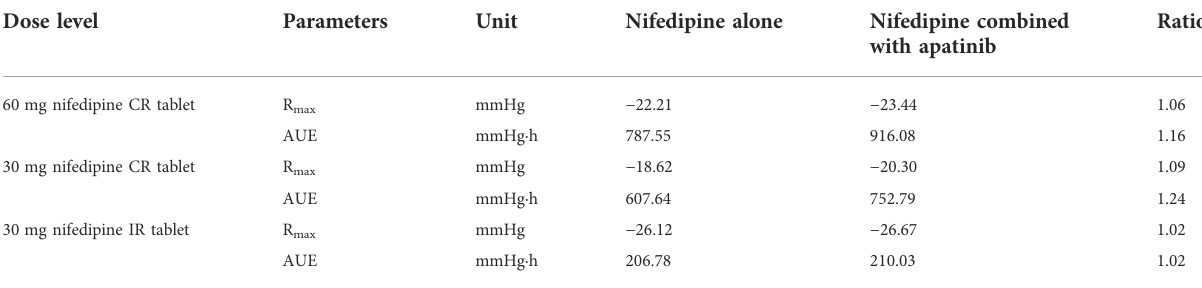
TABLE 6 Calculated R max and AUE ratio in the presence to the absence of apatinib in cancer patients. Dose level